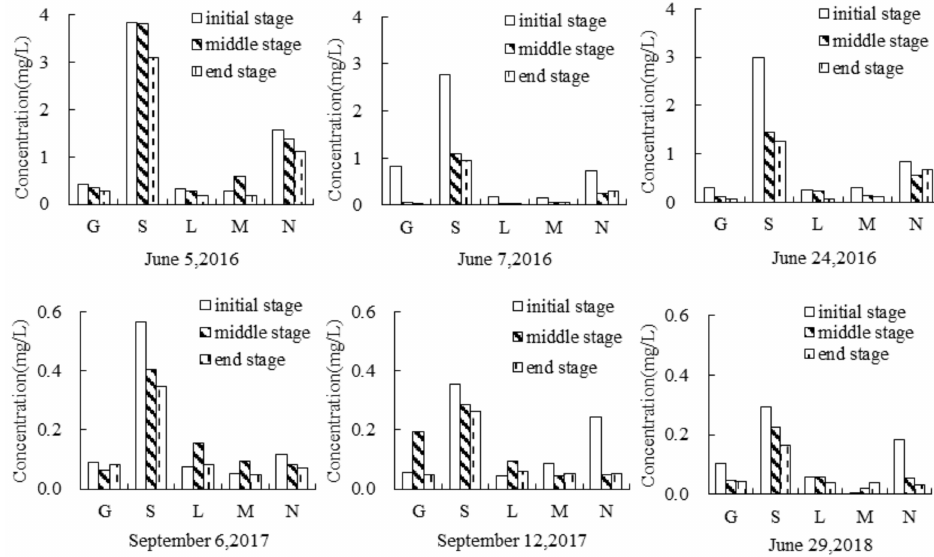
Figure 7. Observed ammonia nitrogen concentration of the subsurface drainage